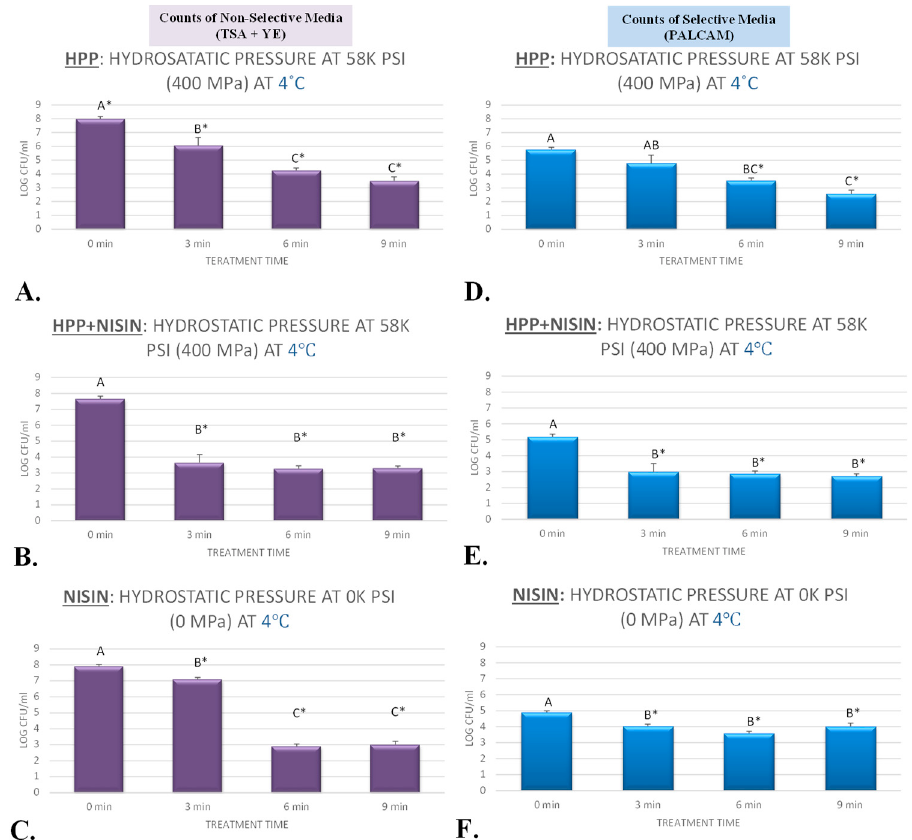
Figure 1. Inactivation of four-strain cocktail of L. monocytogenes (ATCC @ 51772, 51779, BAA-2657, and 13932) in sterilized phosphate-buffered saline, treated by nisin (5000 IU/mL) and elevated hydrostatic pressure at 400 MPa (Barocycler Hub880 Explore, Pressure Bioscience Inc., Easton, MA, USA) for 0, 3, 6, and 9 min at 4 °C. In each graph and for each microbiological medium (PALCAM (selective counts), TSA + YE (nonselective counts)) separately, columns of each time interval followed by different uppercase letters are representing log CFU/mL values (Mean ± SD) that are statistically ( p ˂ 0.05) different (Tukey-adjusted ANOVA). Uppercase letters followed by * sign are statistically ( p ˂ 0.05) different than untreated control (not treated with antimicrobial) (Dunnett’s-adjusted ANOVA). ( A ) Nonselective counts (Tryptic Soy Agar + yeast extract [TSA + YE]), treated by hydrostatic pressure at 400 MPa (58 K pound-force per square inch [PSI]) at 4 °C; ( B ) Nonselective counts (TSA + YE), treated by hydrostatic pressure at 400 MPa (58 K PSI) and exposed to nisin (5000 IU/mL) at 4° C; ( C ) nonselective counts (TSA + YE), only exposed to nisin (5000 IU/mL) at 4 °C. ( D ) Selective counts (PALCAM), treated by hydrostatic pressure at 400 MPa (58 K PSI) at 4 °C; ( E ) Selective counts (PALCAM), treated by hydrostatic pressure at 400 MPa (58 K PSI) and exposed to nisin (5000 IU/mL) at 4° C; ( F ) Selective counts (PALCAM), only exposed to nisin (5000 IU/mL) at 4 °C.